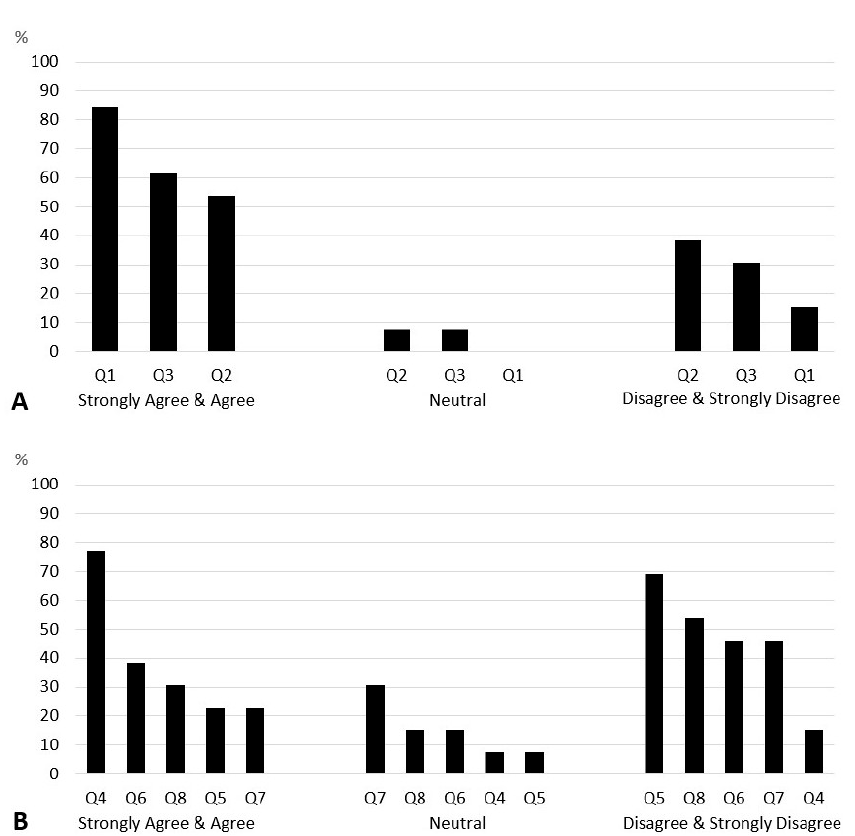
Figure 4. Percentage distribution of positive, neutral, and negative answers connected to technical ( A ) and usefulness ( B ) aspects of app functions.